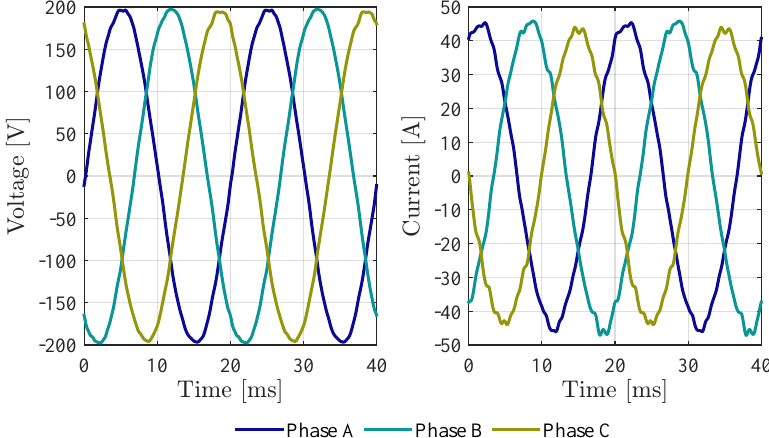
Figure 18. Voltage and current waveforms for scenario (4): mitigating the harmonic, balancing the three-phase currents, compensating the reactive power and posteriorly dispatching 12